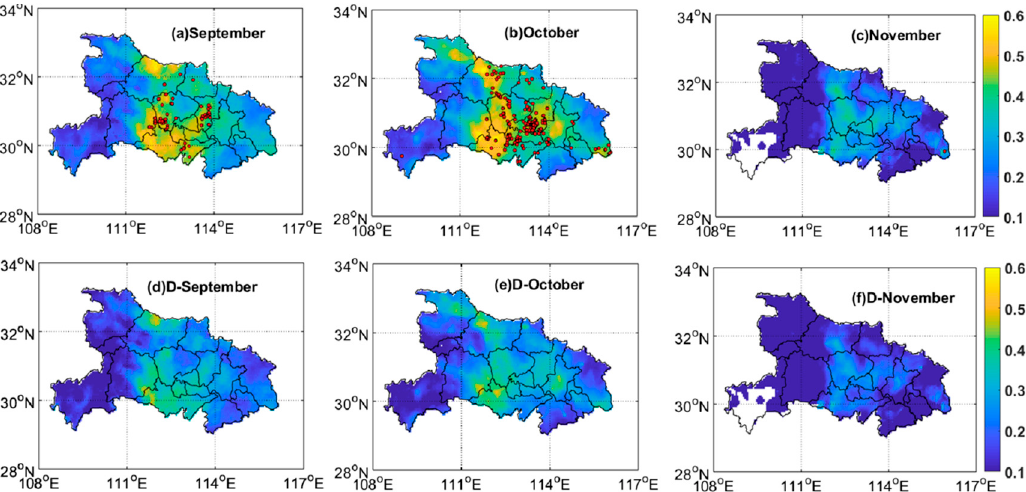
Figure 3. Average distributions of AOD (from ( a ) to ( c )) and the corresponding difference (from ( d ) to ( f )) with the mean value of AOD over two years (July 2015 to July 2017) in Hubei Province. The red point in each subplot represents the location of fire spot for each month.